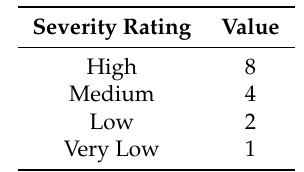
Table 1. Severity ratings and